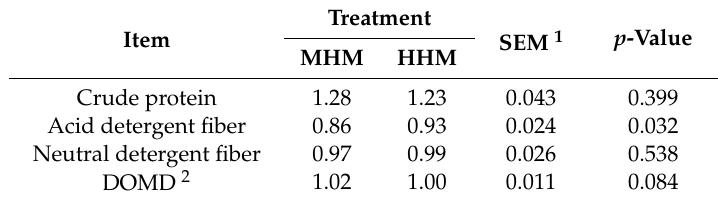
Table 6. Nutrient selection di ff erential after the end of the first grazing session in a pasture with a medium (MHM) and high (HHM) pre-grazing herbage mass grazed by dairy cows.